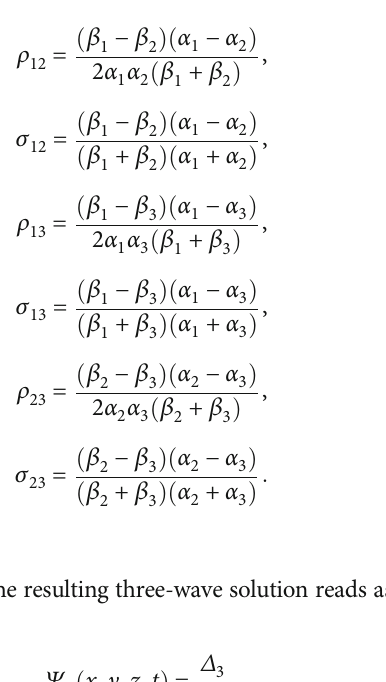
= 2, y = 10, and z = 2 . 2